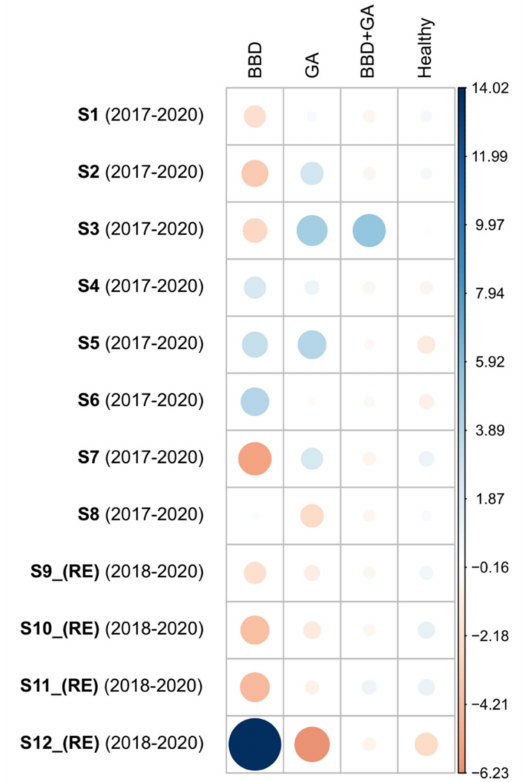
Figure 5. Associations between the sites surveyed in this study (2017–2020) and the occurrence of BBD, GAs, and BBD + GAs (i.e., both diseases occurring at the same time/comorbidity) on encrusting Montipora colonies, as well with the presence of healthy Montipora colonies (unaffected by BBD or GAs). Circle sizes and color intensity represent the strength of the association. Blue color = positive associations (i.e., higher occurrence), Red color = negative associations (i.e., lower